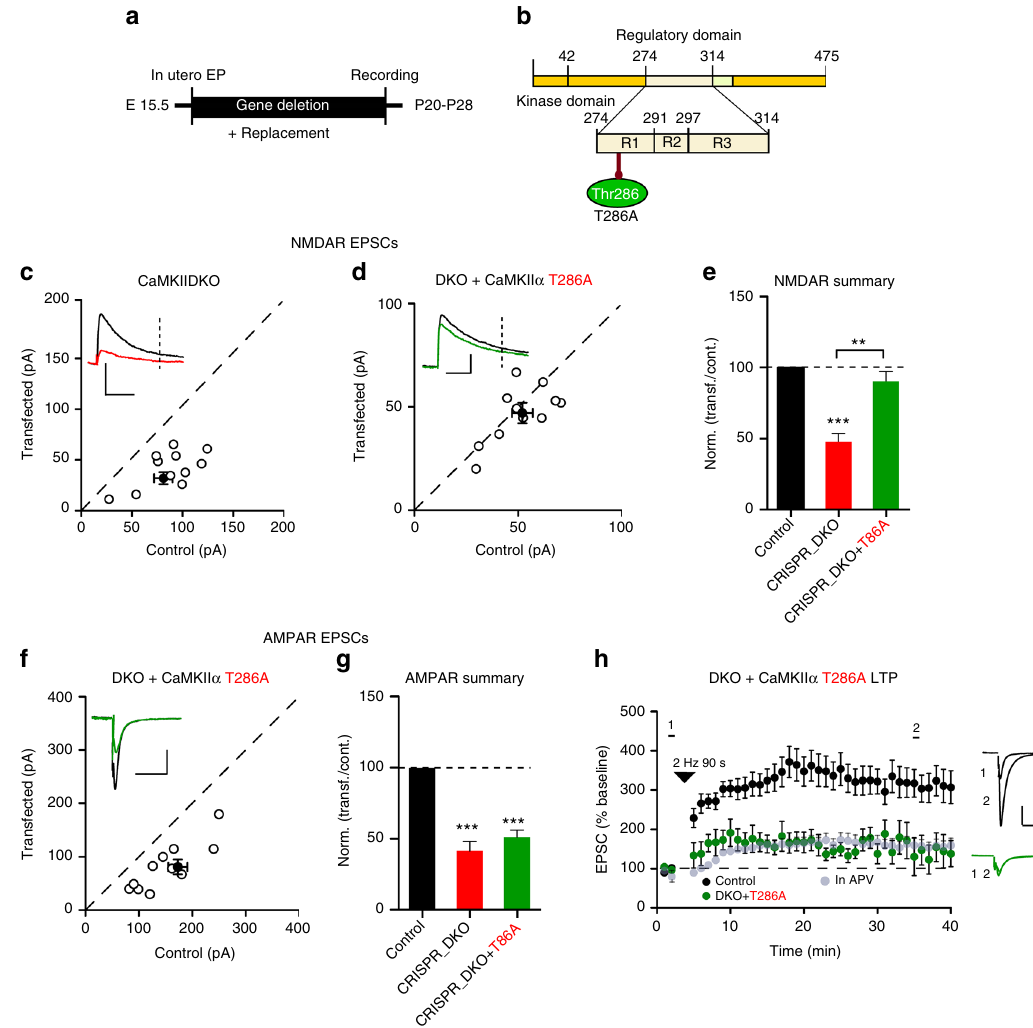
Fig. 6 Cells expressing CaMKII α T286A lack LTP. a Timeline of the experiment. b Scheme of the structural organization of CaMKII α with the point mutation that makes CaMKII autophosphorylation impaired (T286A light green) indicated. c , d Scatterplots show single pairs (open circles) of control and transfected cells of DKO ( c , n = 9 pairs), and DKO + T286A ( d , n = 9 pairs). Filled circles indicate mean ± SEM ( c , Control = 81.9 ± 9.4; DKO = 39.1 ± 6.43, p = 0.003; d , Control = 52.6 ± 4.9; DKO + CaMKII α T286A = 47 ± 4.8, p = 0.31). e Bar graph of ratios normalized to control (%) summarizing the mean ± SEM of NMDAR EPSCs of values represented in c (47.8 ± 5.9, p = 0.001) and d (90.3 ± 7.1, p = 0.31). f Scatterplot shows amplitudes of AMPAR EPSCs for single pairs (open circles) of control and transfected of DKO + T286A ( d , n = 10 pairs). Filled circle indicates mean ± SEM ( f , Control = 153.6 ± 18.5; DKO + CaMKII α T286A = 81.4 ± 14.8, p = 0.002). g Bar graph of ratios normalized to control (%) summarizing the mean ± SEM of AMPAR EPSCs of values represented in f (51.1 ± 4.8, p < 0.001). DKO data (red bar) from Fig. 2f are included in the graph. h Plots showing mean ± SEM AMPAR EPSC amplitude of control (black) and transfected (green) DKO + CaMKII α T286A pyramidal neurons normalized to the mean AMPAR EPSC amplitude before LTP induction (arrow) (Control, n = 10; DKO + CaMKII α T286A, n = 6, p = 0.0077 at 35 min). Sample AMPAR EPSC current traces from control (black) and electroporated neurons (green) before and after LTP are shown to the right of each graph. Gray plots represent mean ± SEM AMPAR EPSC amplitude of LTP induction in APV 50 μ M. Raw amplitude data from dual cell recordings were analyzed using Wilcoxon signed rank test ( p values indicated above). Normalized data were analyzed using a one-way ANOVA followed by the Mann − Whitney test (*** p < 0.0001). Mann − Whitney test was also used to compare LTP at 35 min ( p values indicated above). Scale bars: 50 ms, 50